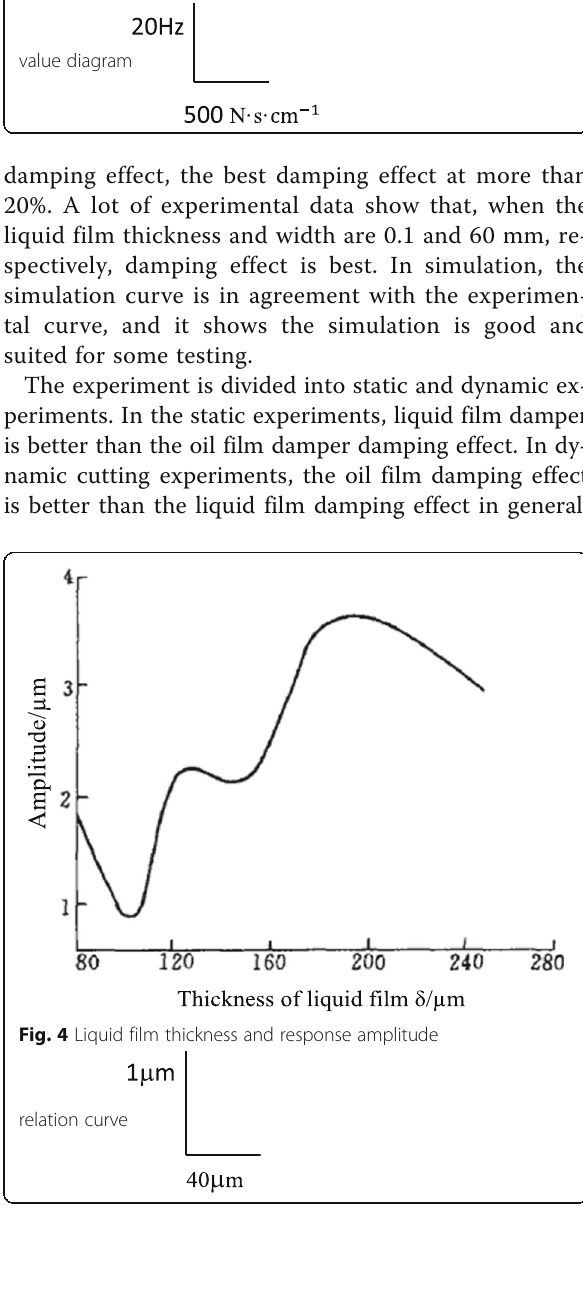
Fig. 3 Resonance frequency and the damping value diagram